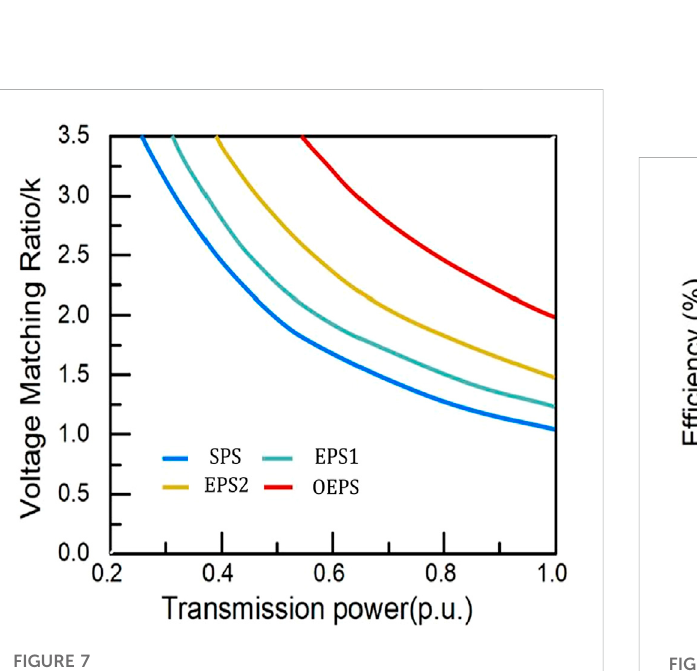
FIGURE 8 Theef fi